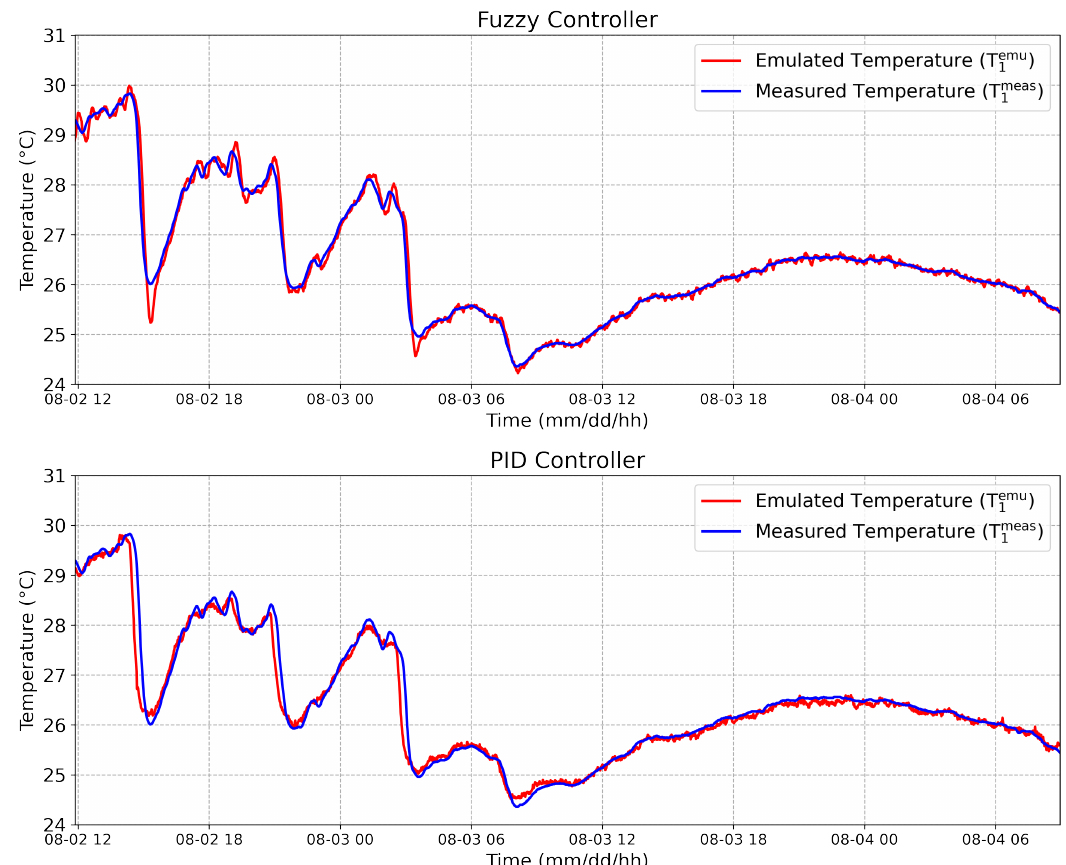
Figure 14. External temperature: Measured temperature on the bottom face T meas emulated temperature on the bottom face, T emu PID controller, respectively.